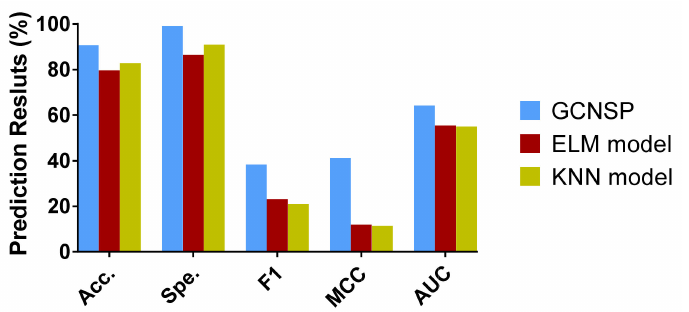
Figure 6. The outcomes of different classifier models in the yeast data set.